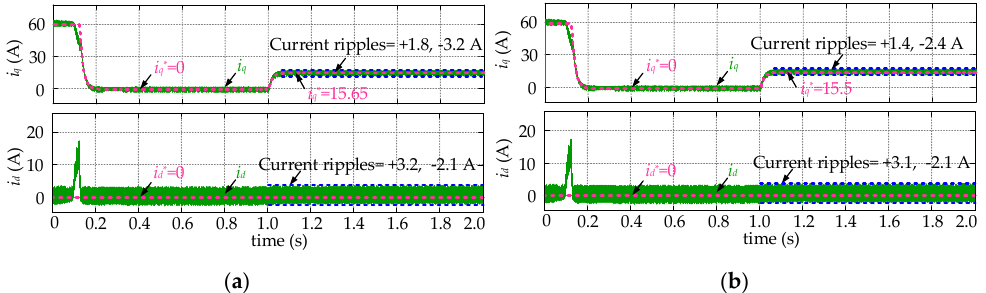
Figure 9. Current control performance of FCS-MPCC without disturbance compensation under di ff erent